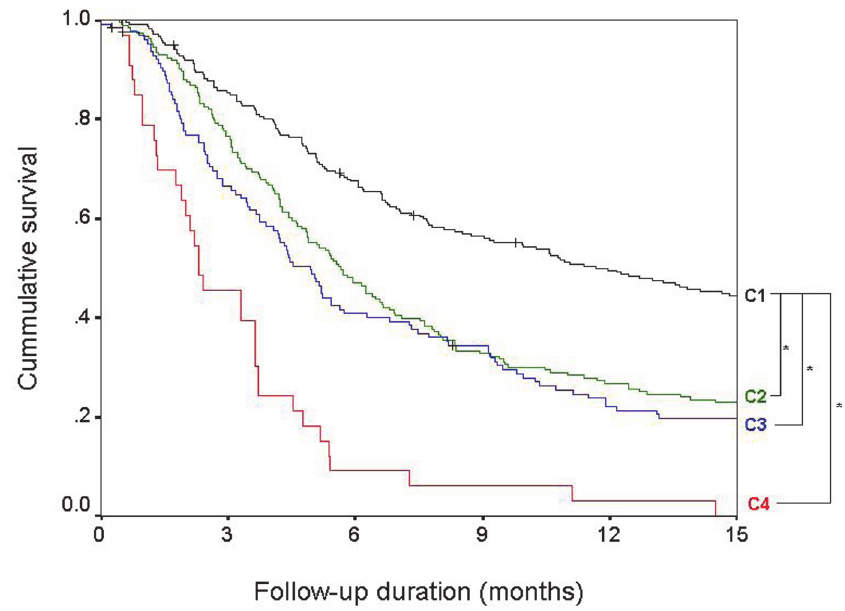
Fig 3. Survival of patients based on the sub-classification. Patient survival was significantly different based on sub-classification of BCLC stage C patients. Sub-stage C1 includes the patients with portal vein invasion limited to the segmental or sectoral branch and extrahepatic spread limited to the nodal area (black). Sub-stage C2 includes the patients with portal vein invasion that extends beyond the right and/or left main branch without distant metastasis (green), and sub-stage C3 includes the patients with distant metastasis, but portal vein invasion limited to the segmental or sectoral branch (blue). Sub-stage C4 includes the patients with portal vein invasion that extends beyond the right and/or left main branch with distant metastasis (red). * P < 0.01.